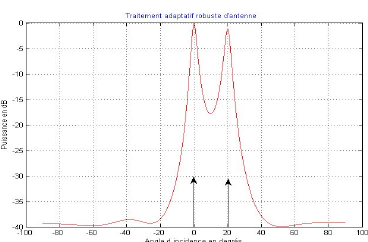
Fig. 8. Direction of arrival of two sources using the robust adaptive